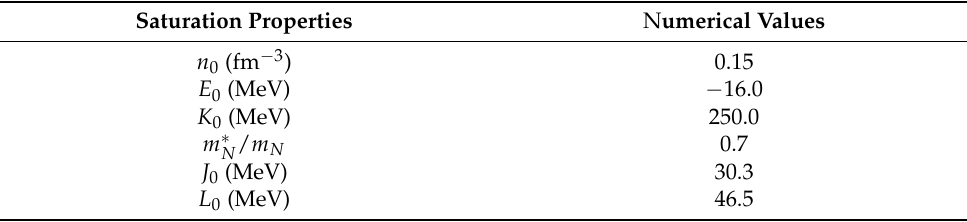
Table 2. Energy per nucleon E 0 , nuclear compressibility K 0 , effective nucleon mass m ∗ , symmetry energy J 0 , and slope of the symmetry energy L 0 of nuclear matter at saturation density, n 0 , obtained for the SW4L